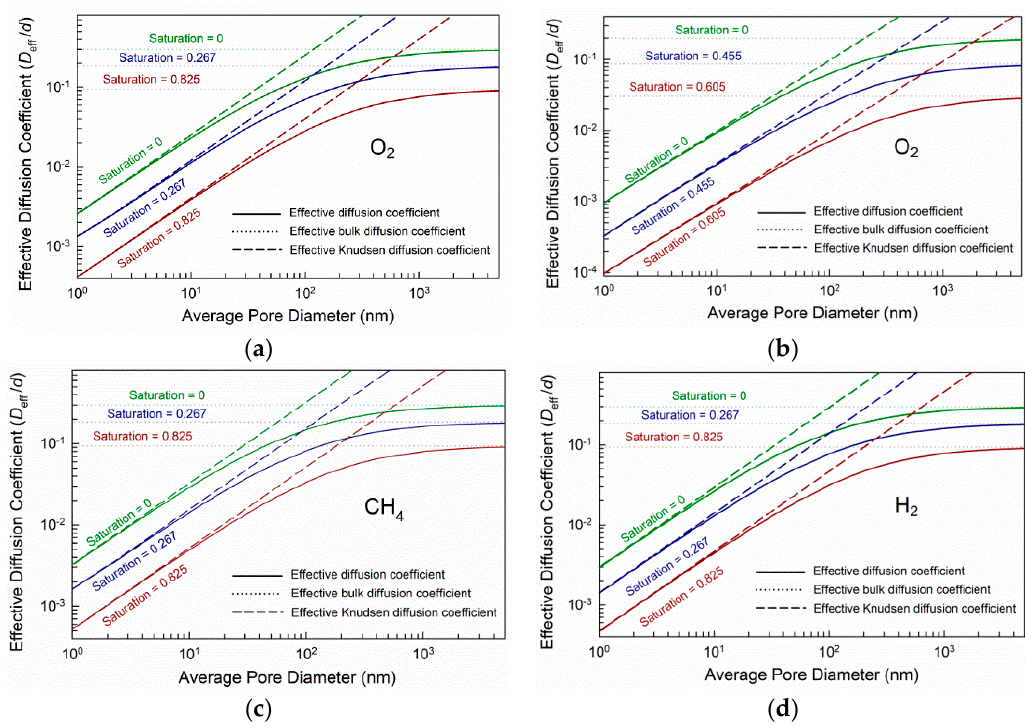
Figure 9. ( a ) Oxygen diffusion in sample 1. ( b ) Oxygen diffusion in sample 2. ( c ) Methane diffusion in sample 1. ( d ) Hydrogen diffusion in sample 1.